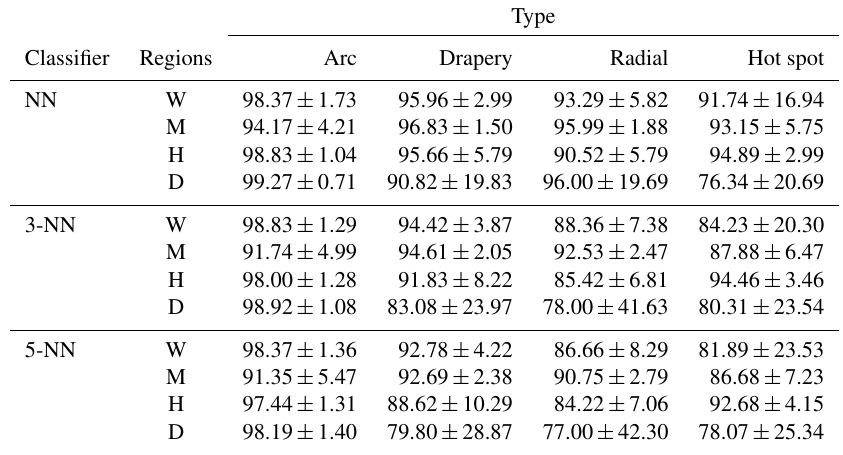
Table 2. Experiment performance from 100 iterations (mean accuracy ± standard deviation %) of the k -NN classifier in different auroral active regions.